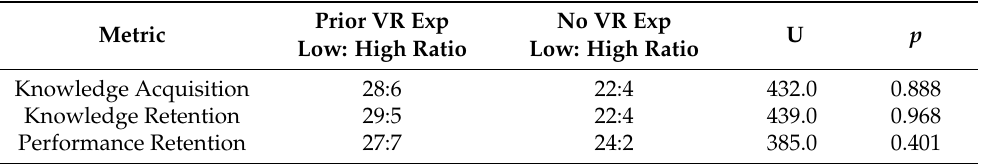
Table 8. Results of Mann–Whitney U tests comparing the distribution differences of low and high performances among participants with or without prior VR